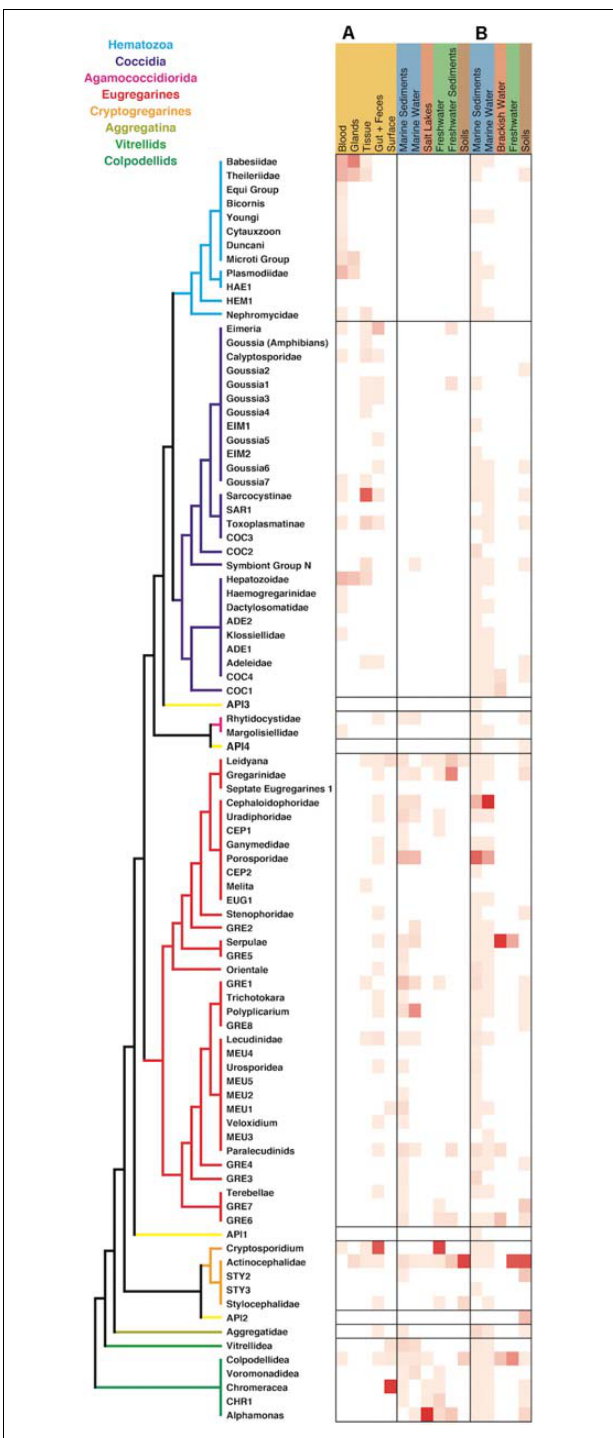
FIGURE 5 | Apicomplexan environment distribution heatmap based on the information associated to the sequences retrieved from (A) GenBank and (B) relative amplicon abundances in HTES studies. The novel lineages obtained only by HTES studies are inserted on the tree shown in Figure 2 , respecting the original topology. Detailed information on the taxonomic annotation of the apicomplexan sequences used in this figure is available in Supplementary Table S1